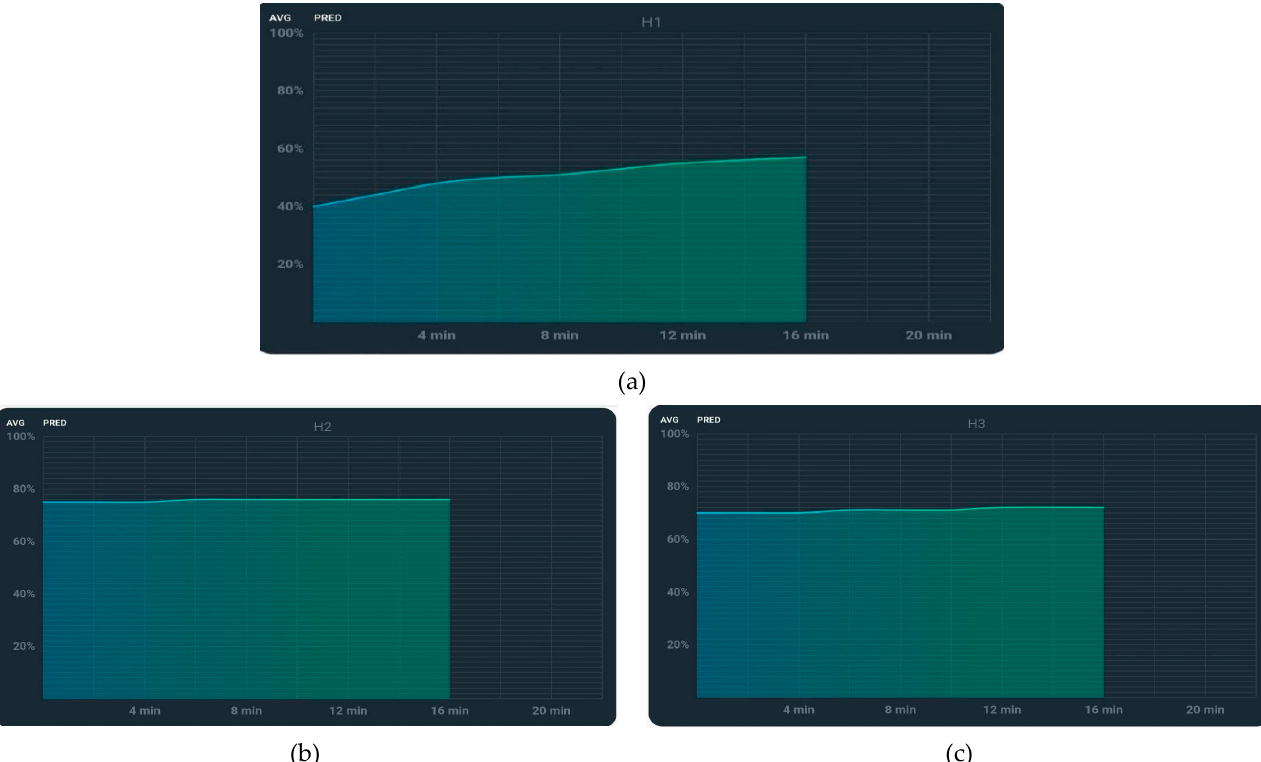
Figure 16. Humidity measurements: ( a ) from location A1, ( b ) from location A2, and ( c ) from location A3.